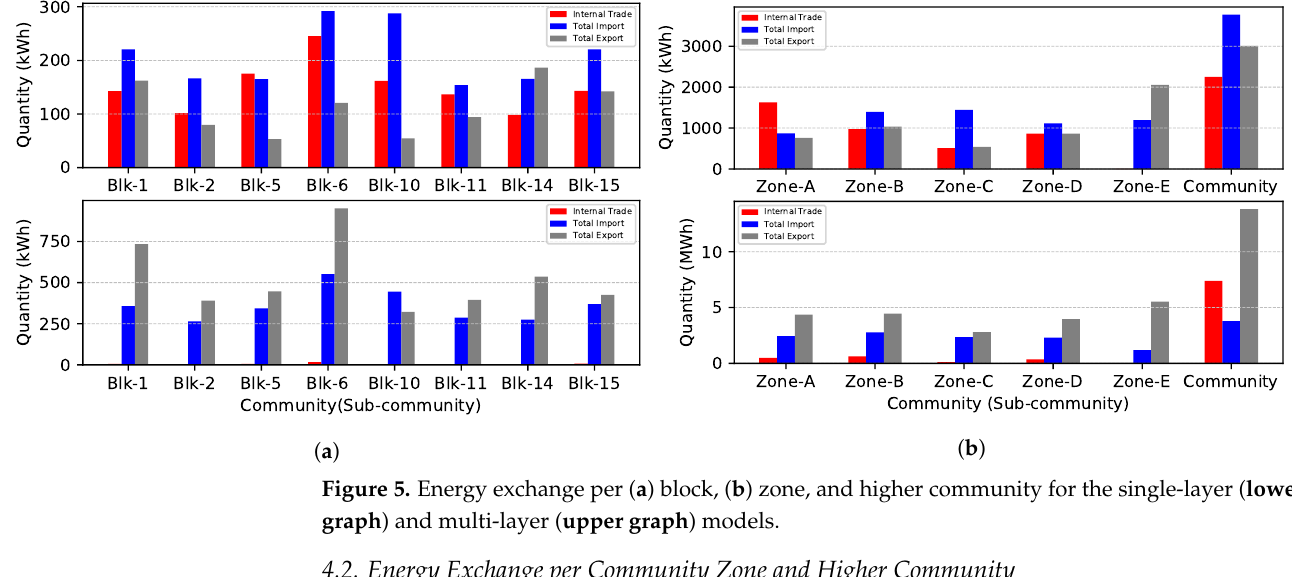
Figure 5. Energy exchange per ( a ) block, ( b ) zone, and higher community for the single-layer ( lower graph ) and multi-layer ( upper graph )